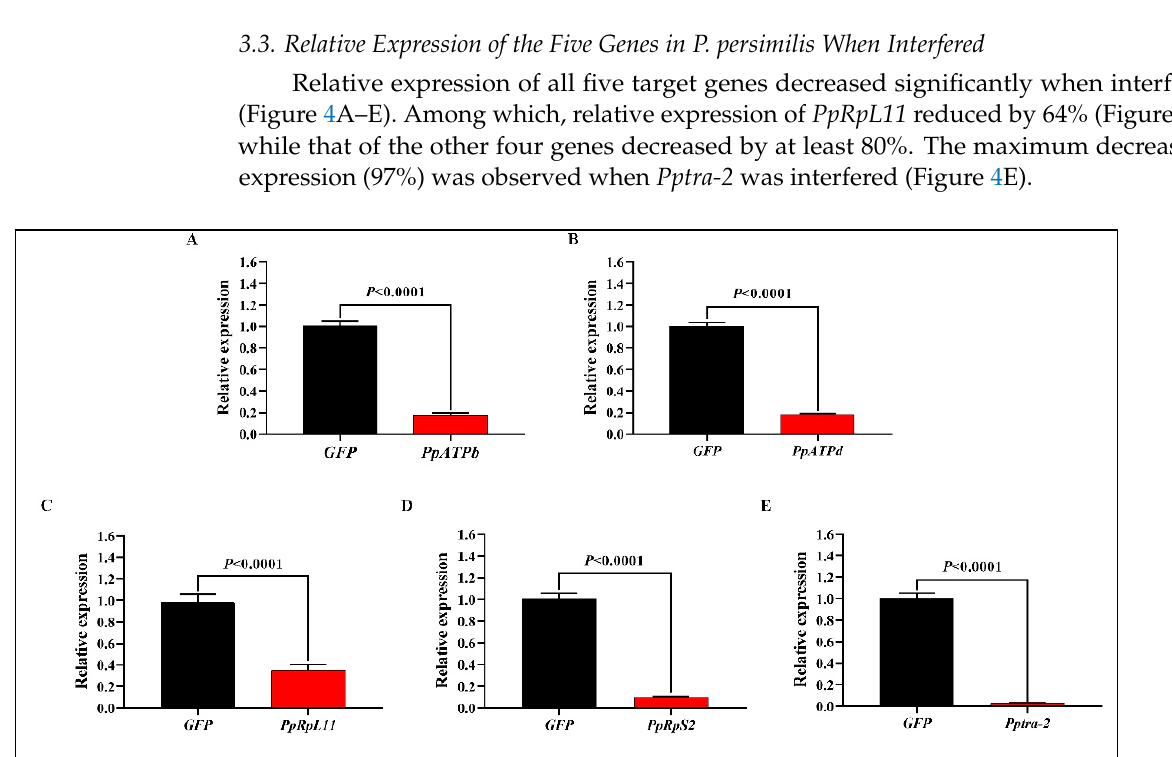
Means within a row followed by different letters are differences across each day (SNK tests: p < 0.05).